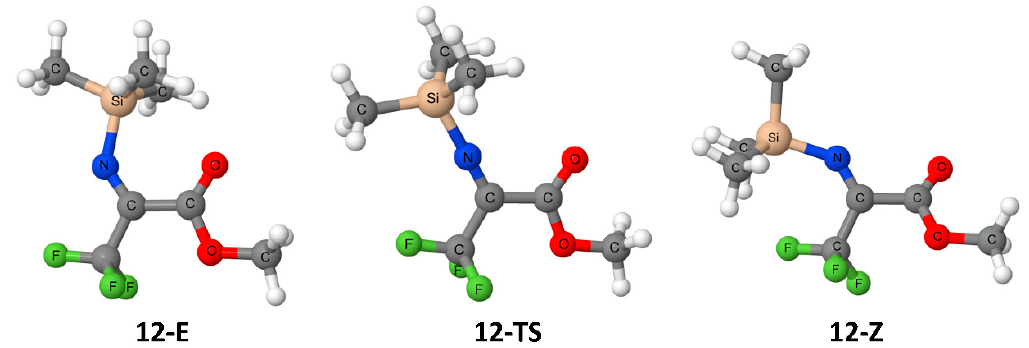
tively), and the structure corresponding to the transition states of the isomerization reaction ( 11-TS ).